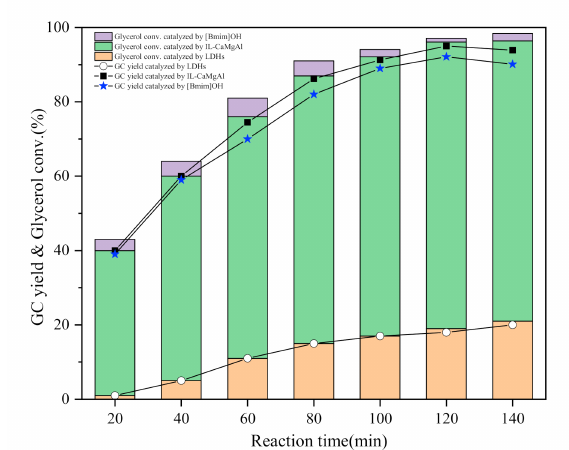
Figure6. Transesterificationofdimethylcarbonateandglycerolcatalyzedby[Bmim]OH,layered double hydroxides (LDHs) and IL-CaMgAl.